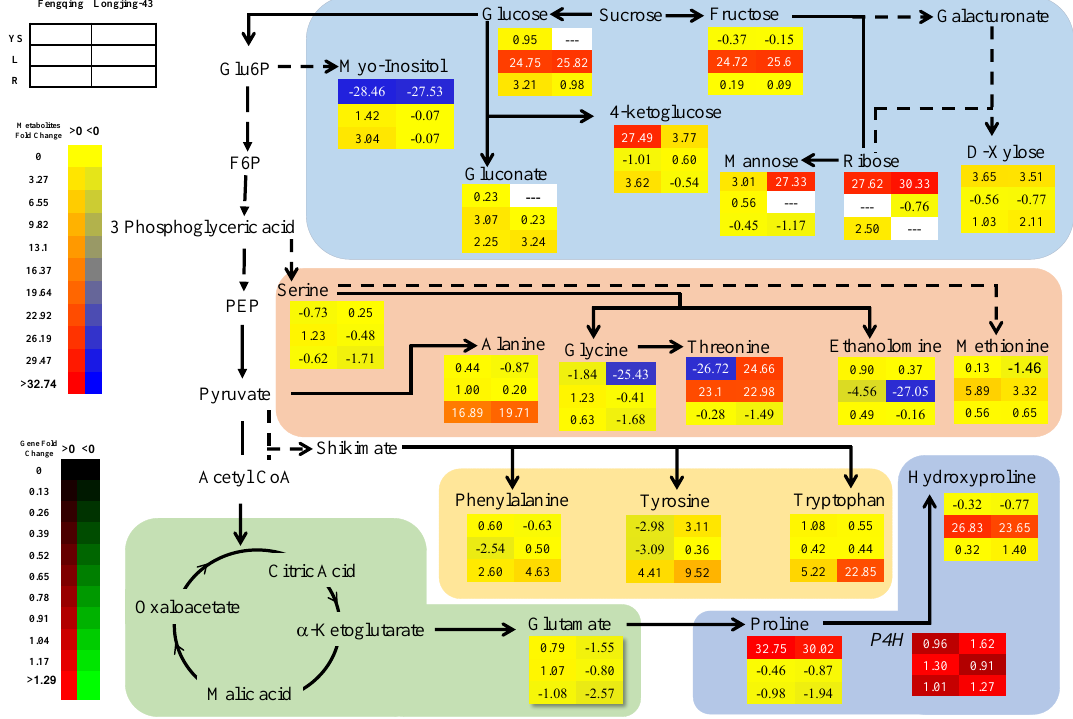
Figure 1. Fold change (log 2[ − P/+P] ) of primary metabolites and P4H a in response to P starvation. Fengqing ( left column ) and Longjing-43 ( right column ) and from the top to the bottom rows are young shoots ( first row ), leaves ( middle row ) and root ( button row ). YS, L and R represents young shoots, leaves, and root, respectively. Metabolites and metabolic genes inside background color box represents different biosynthesis pathway. The solid arrow shows direct and dotted arrow represents speculated steps in the pathway. The data depicted from Table S1 and Table 5, positive as increase and negative as decrease in fold change. On the false color scale red indicates increase; blue and green indicates decrease in metabolites and gene. a P4H means prolyl 4-hydroxylase